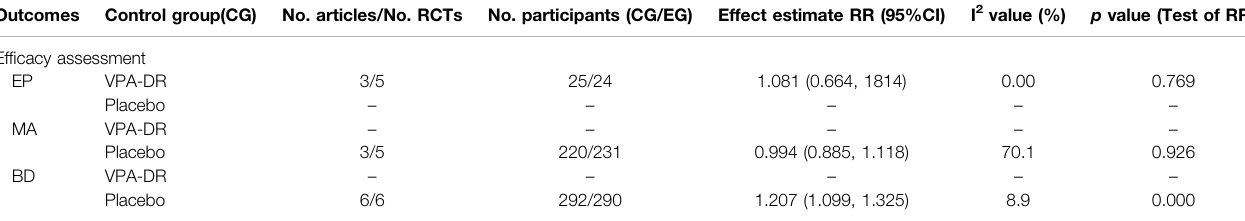
TABLE 2 | Pooled estimated data of ef fi